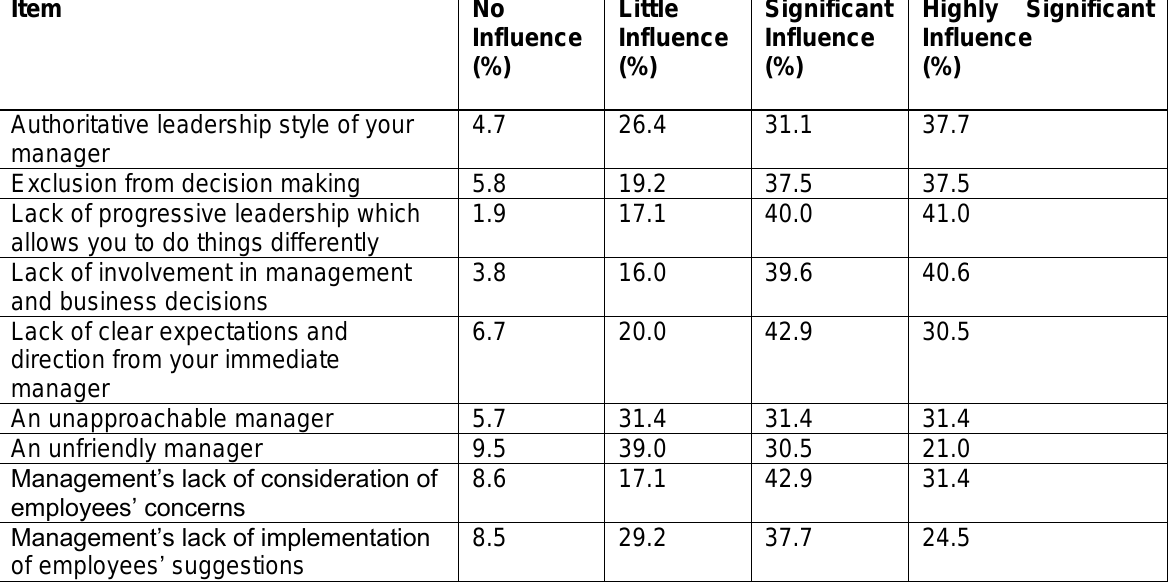
Table 4: Perceived influence of leadership/management style on respondents’ consideration to leave